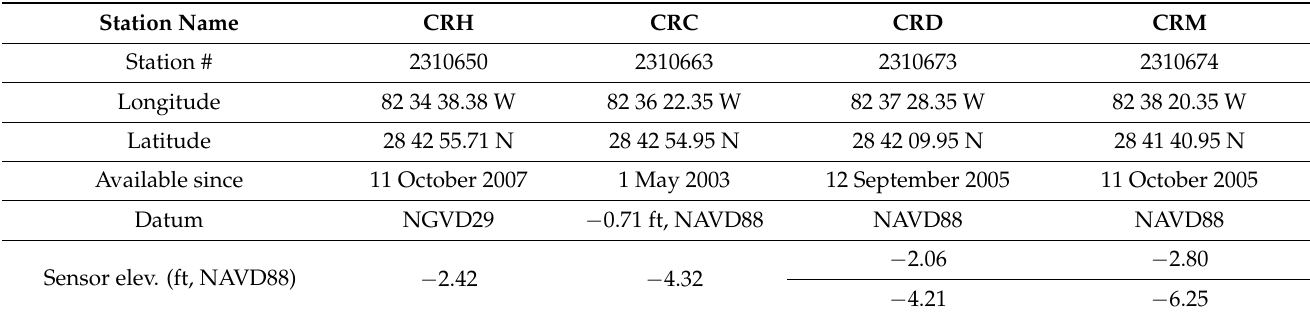
Table 1. General information about the USGS CDT data collection stations in the Chassahowitzka River.